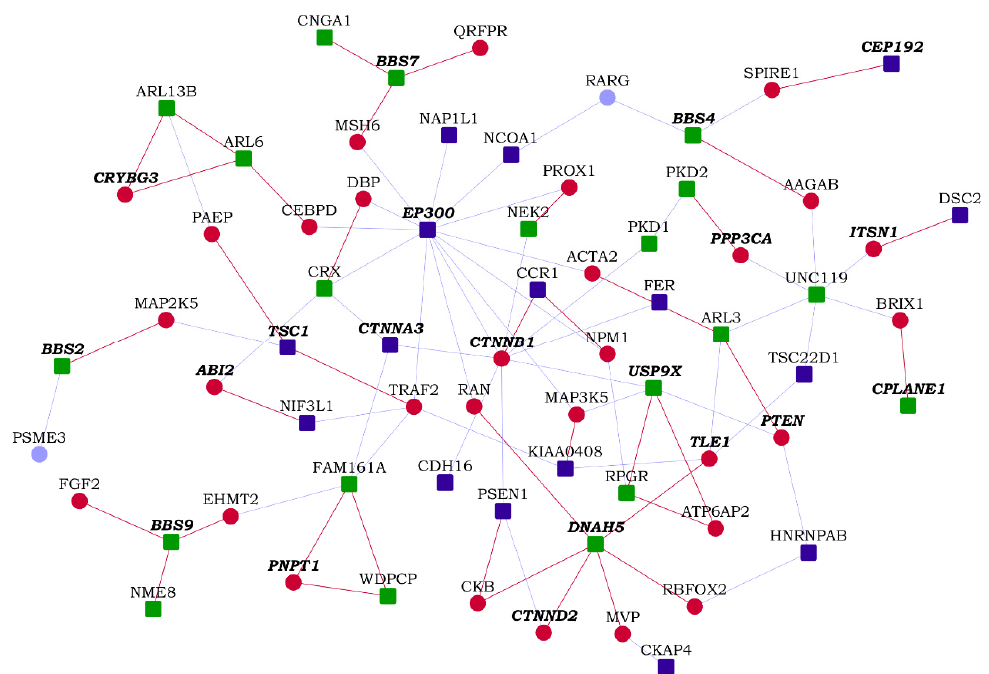
Figure 8. A partial network view of novel protein–protein interactions (PPIs) interconnecting hypoplastic left heart syndrome (HLHS) genes with ciliopathy-associated genes: Genes are shown as nodes and PPIs as edges. As the integrated HLHS and ciliopathy interactome is very large, only a partial view incorporating genes that are associated with intellectual disability and/or developmental delay (ID/DD) and the novel interactors of HLHS-associated genes/ciliopathy-associated genes are shown. Legend—square-shaped dark blue nodes: HLHS-associated genes; square-shaped green nodes: ciliopathy-associated genes; nodes with bold and italicized labels: ID/DD-associated genes; red nodes/edges: novel interactors/interactions; light blue nodes/edges: known interactors/interactions.